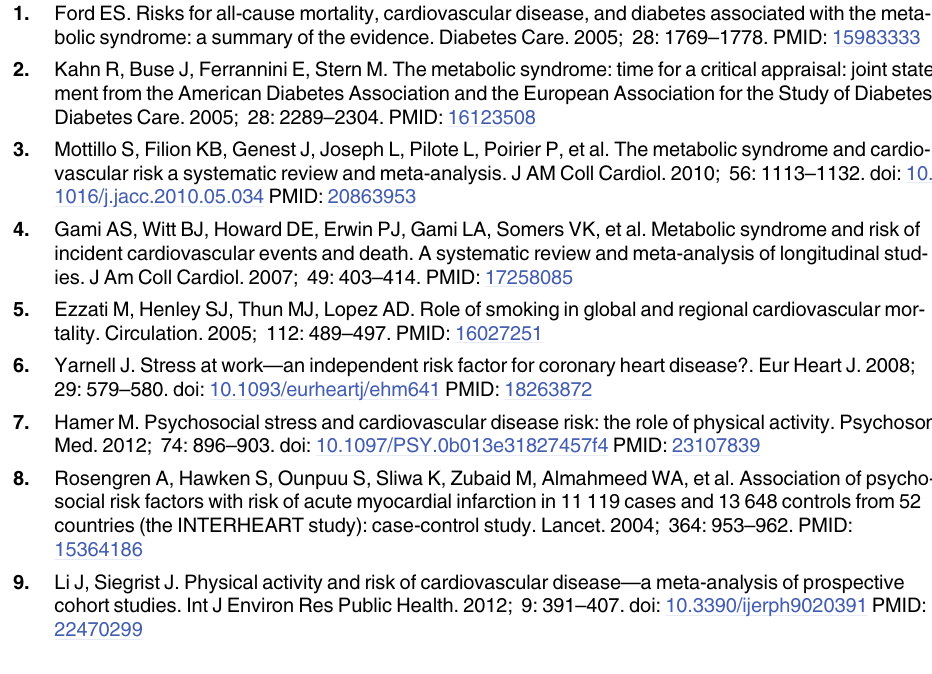
S1 Table. Spearman correlation coefficients between metabolic components, pro-inflam- matory markers, FMD, carotid IMT, blood pressure and perceived stress. S2 Table. Spearman correlation coefficients between the pulmonary function parameters, BMI, metabolic syndrome components and pro-inflammatory